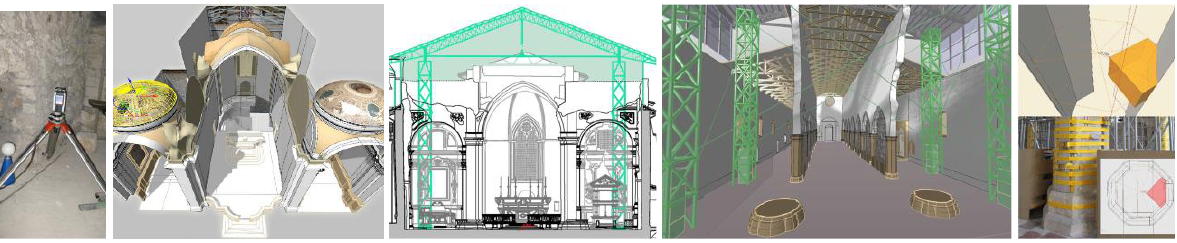
Figure 1. Some images of the BIM of the Basilica di Santa Maria di Collemaggio (L’Aquila).